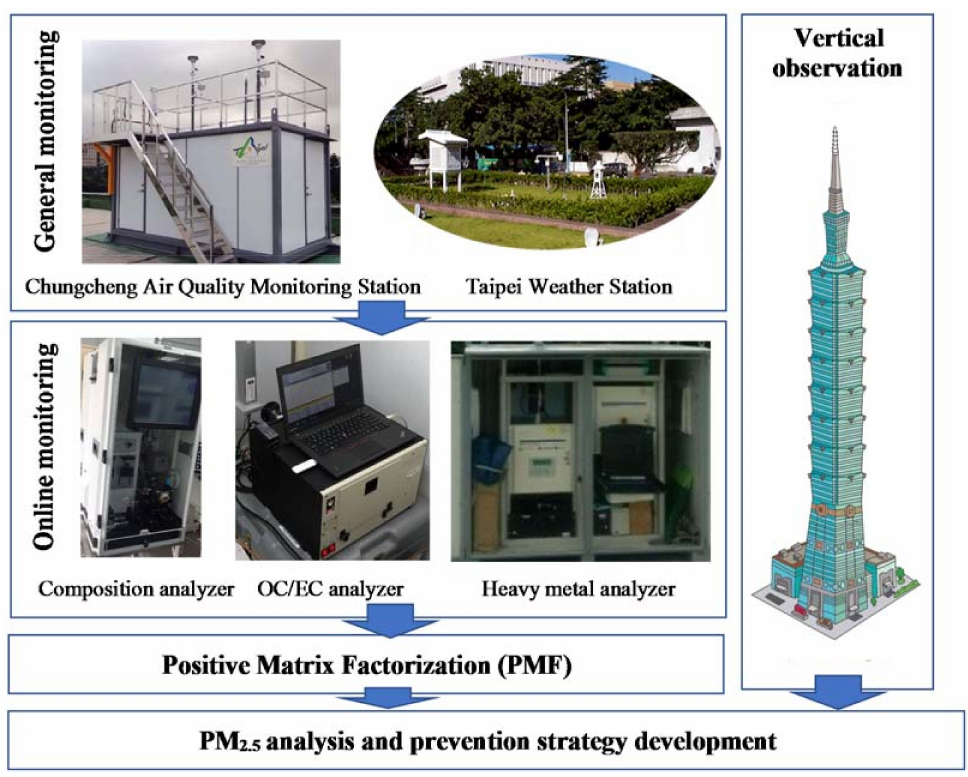
Figure 2. Monitoring infrastructure and data analysis